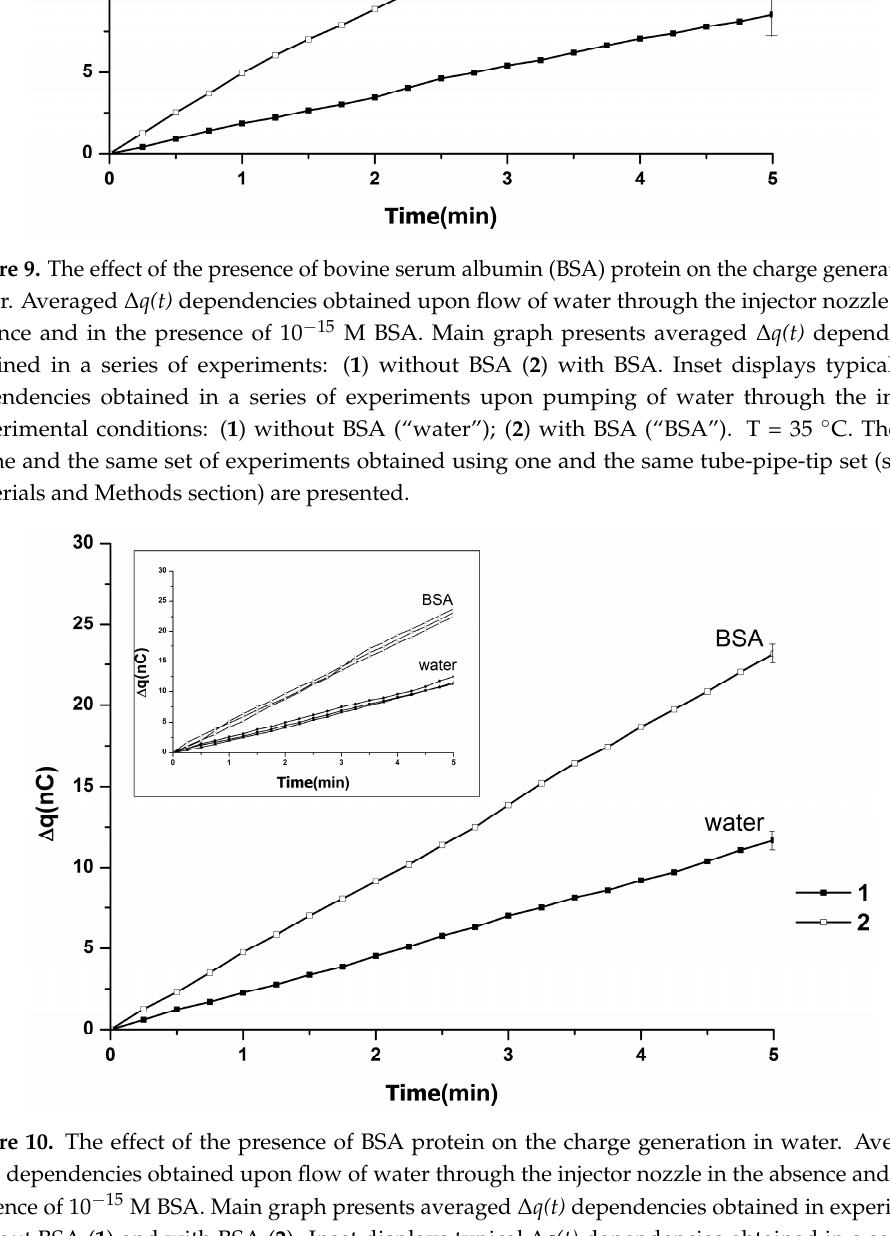
Figure 10. The effect of the presence of BSA protein on the charge generation in water. Averaged ∆ q(t) dependencies obtained upon flow of water through the injector nozzle in the absence and in the presence of 10 − 15 M BSA. Main graph presents averaged ∆ q(t) dependencies obtained in experiments without BSA ( 1 ) and with BSA ( 2 ). Inset displays typical ∆ q(t) dependencies obtained in a series of experiments upon pumping of water through the injector. Experimental conditions: ( 1 ) without BSA (“water”); ( 2 ) with BSA (“BSA”). T = 35 ◦ C. The data of one and the same set of experiments obtained using one and the same tube-pipe-tip set (see the Materials and Methods section) are